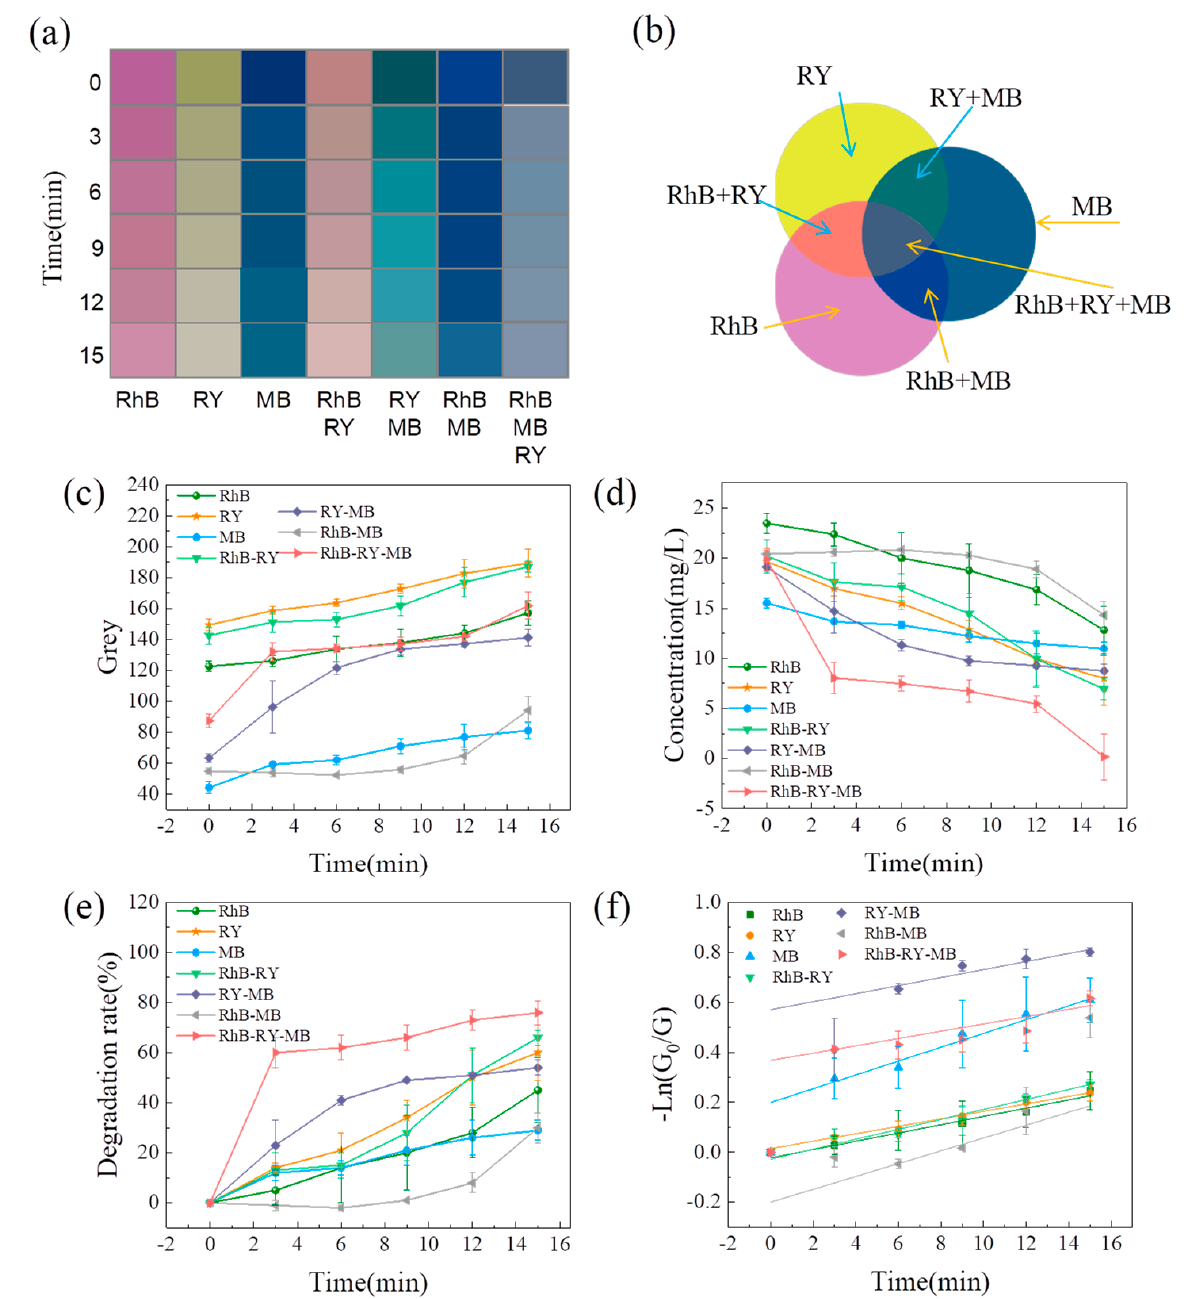
Figure 2. ( a ) Color blocks of different dye samples obtained by the PMTs method; ( b ) the CMYK principle corresponding to the configuration of dye solutions; variation of ( c ) grey value, ( d ) concentration, ( e ) degradation rate, and ( f ) pseudo-first-order reaction kinetics of different dye solutions during the photocatalytic degradation process.